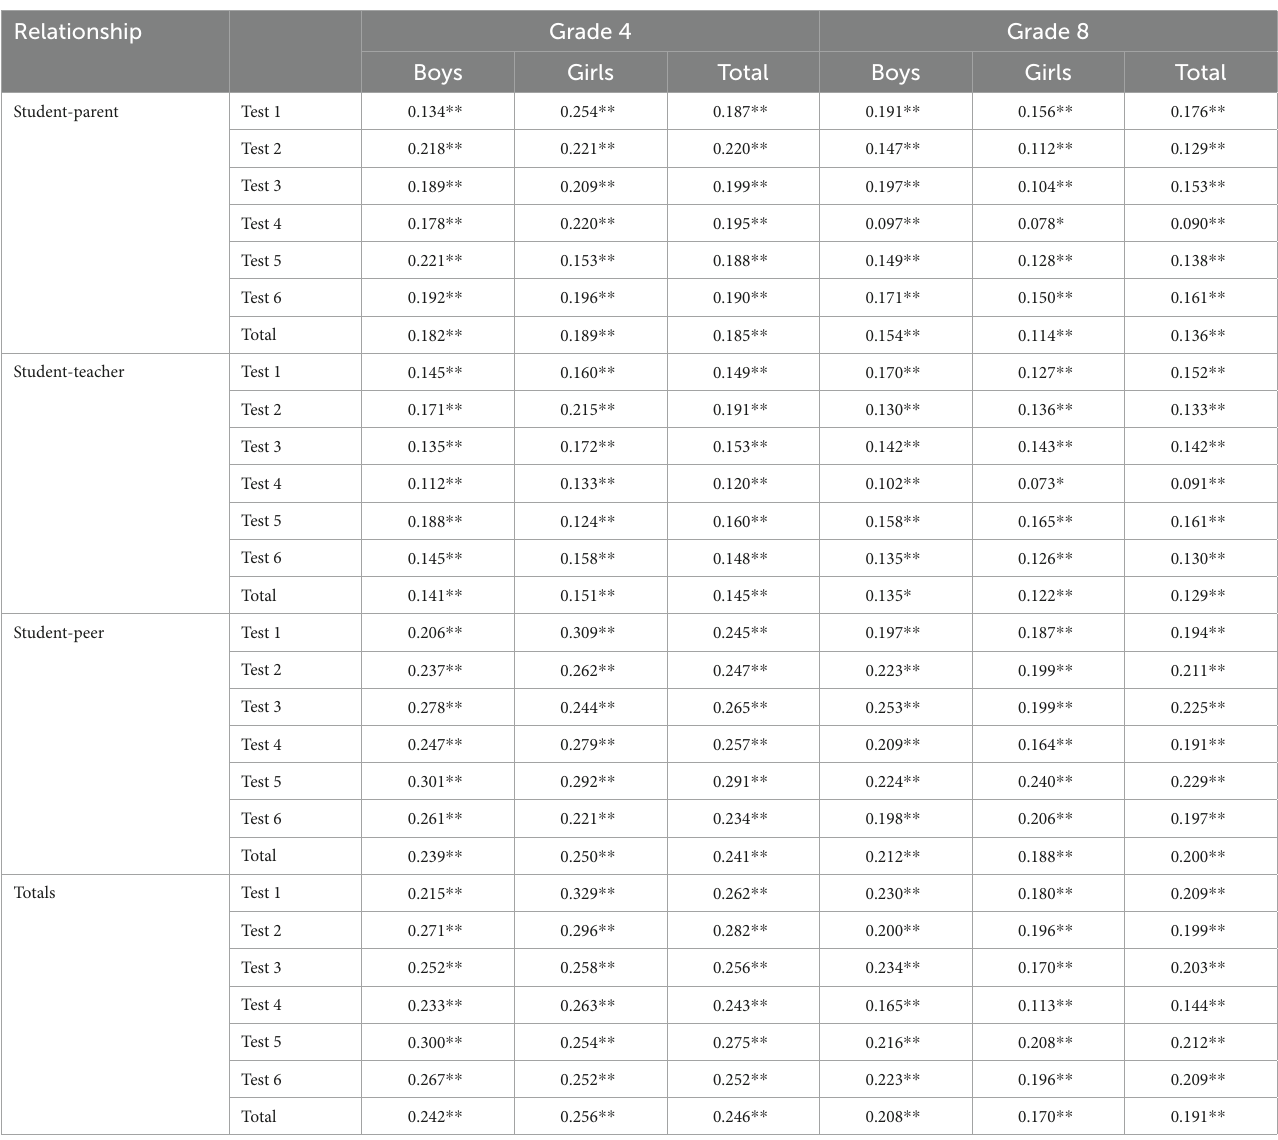
TABLE 3 Correlations between personal relationships and math scores.